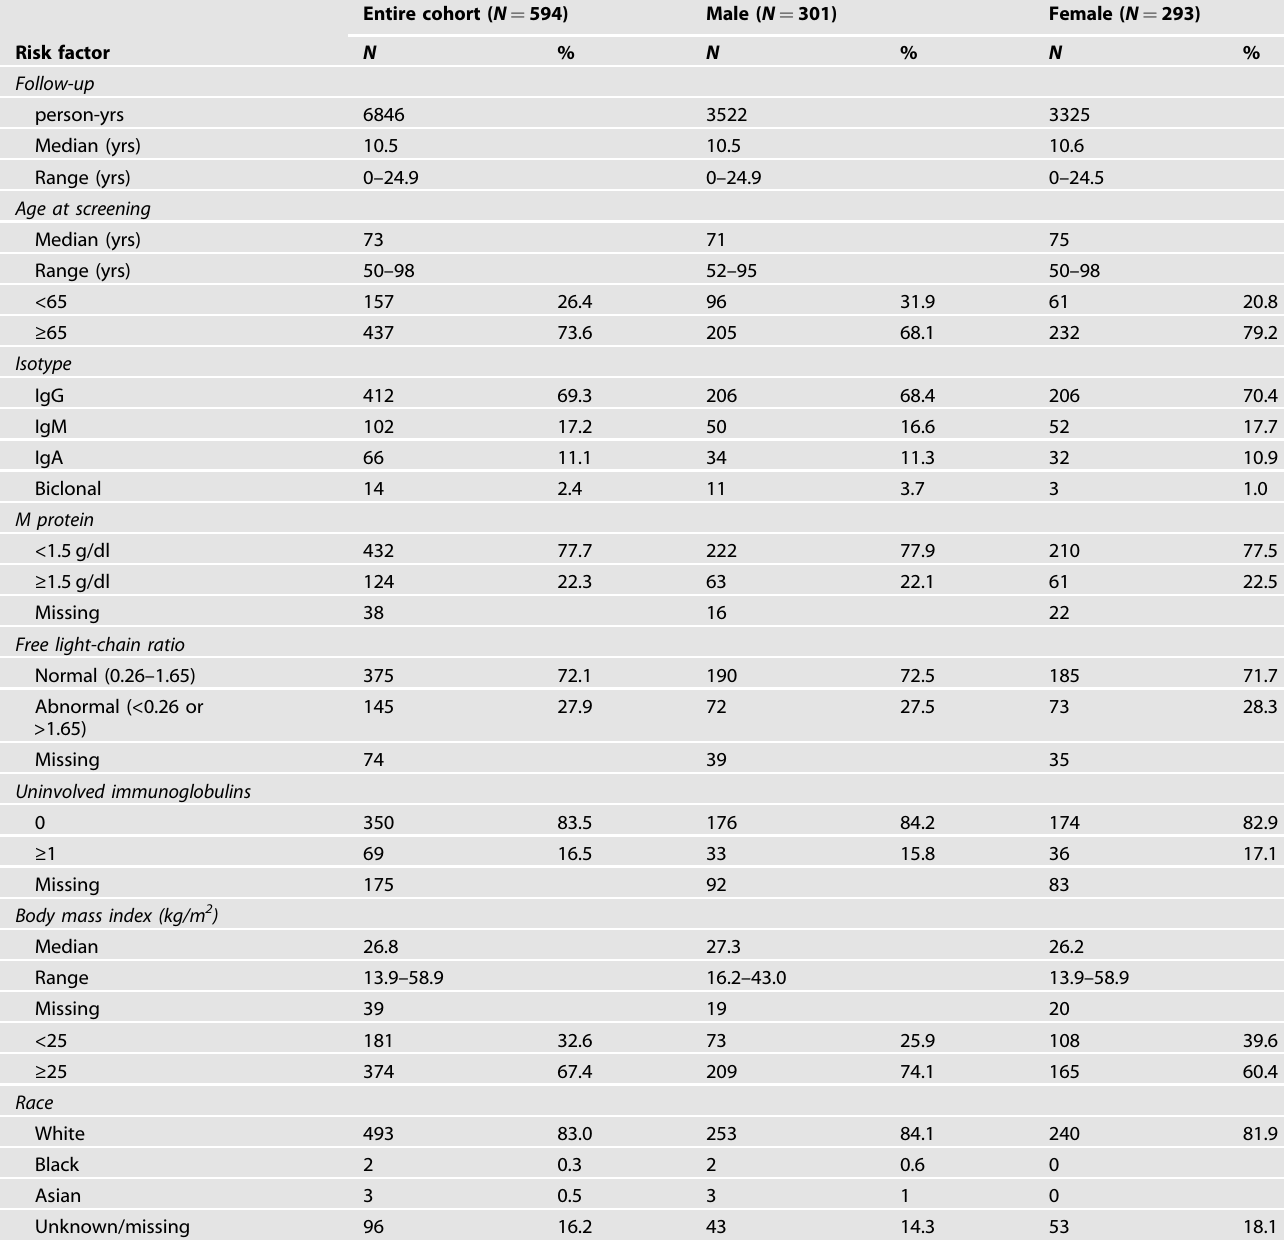
Table 1. Clinical characteristics of MGUS patients in the entire cohort and by